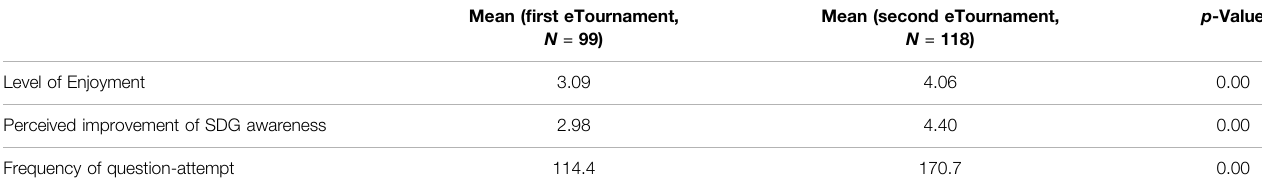
TABLE 4 | Independent-sampled t -test between students in fi rst and second eTournament.